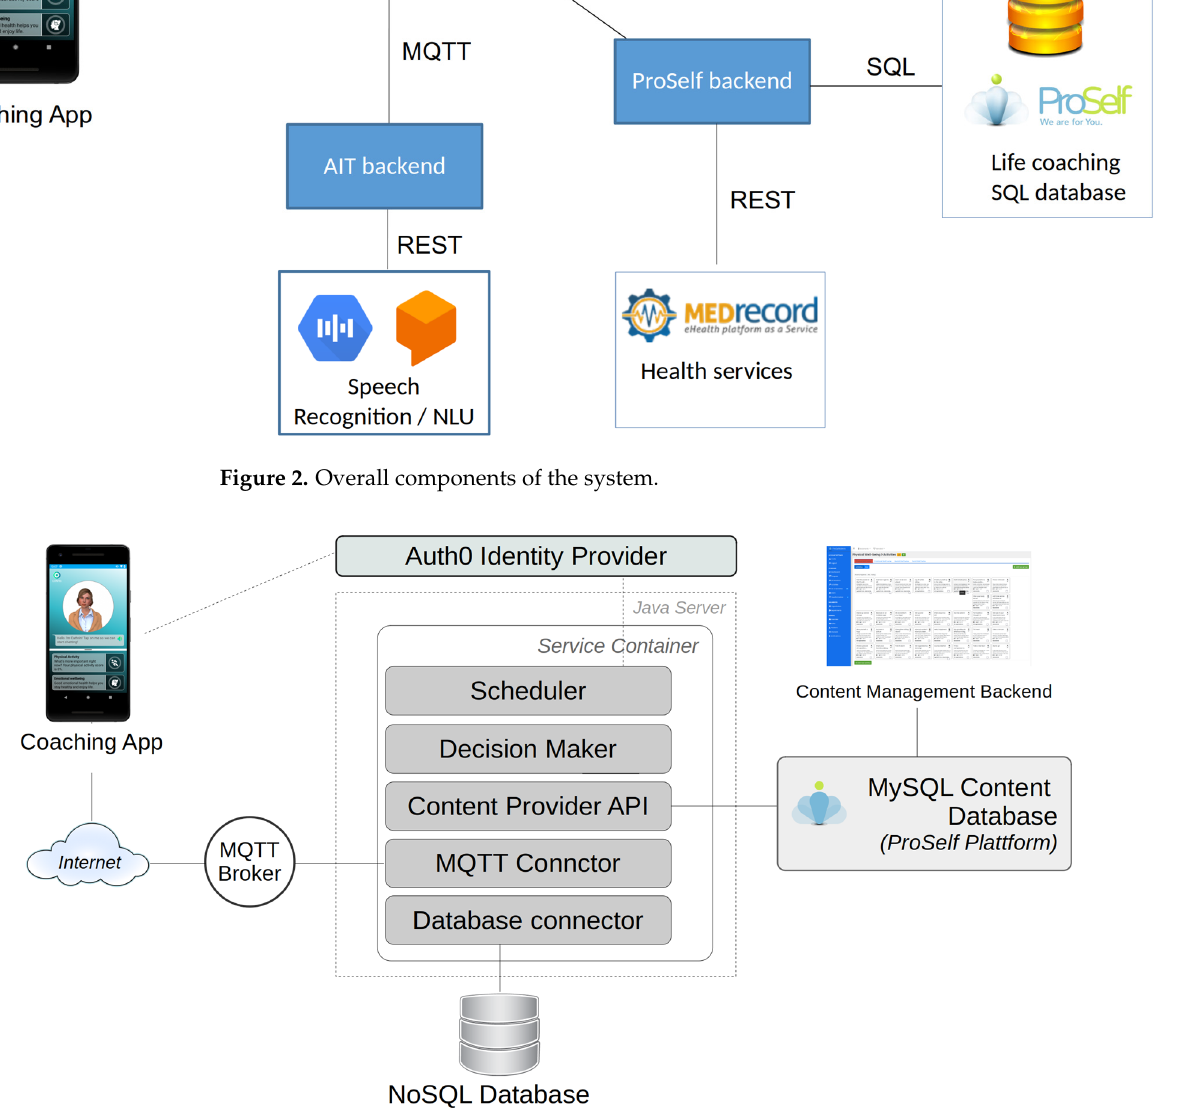
Figure 3. Components of the AgeWell server.